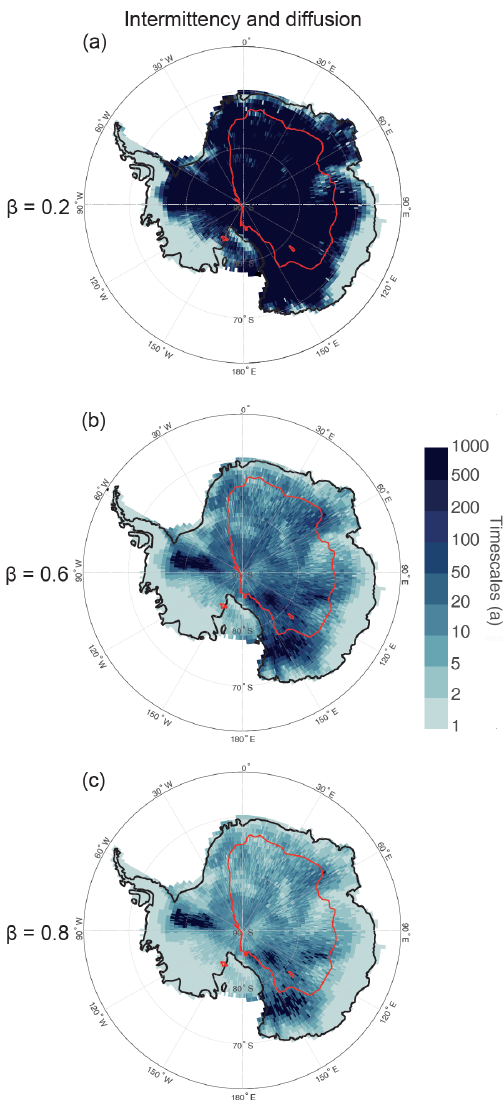
Figure 6. Maps of the signal retrieval timescales τ a after block av- eraging for the case of precipitation intermittency, diffusion, and measurement error (0.1‰ 2 total variance) affecting the signal and for climate spectrum scaling exponents of (a) β = 0 . 2, (b) β = 0 . 6, and (c) β = 0 . 8. The red line marks the contour of an accumulation of 25cmw.e.; see also Fig.